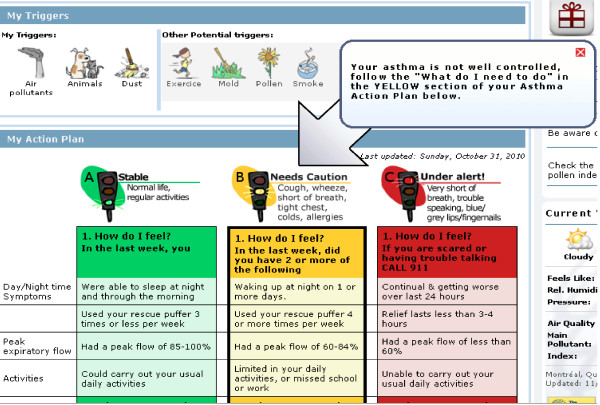
MAP Action Plan.